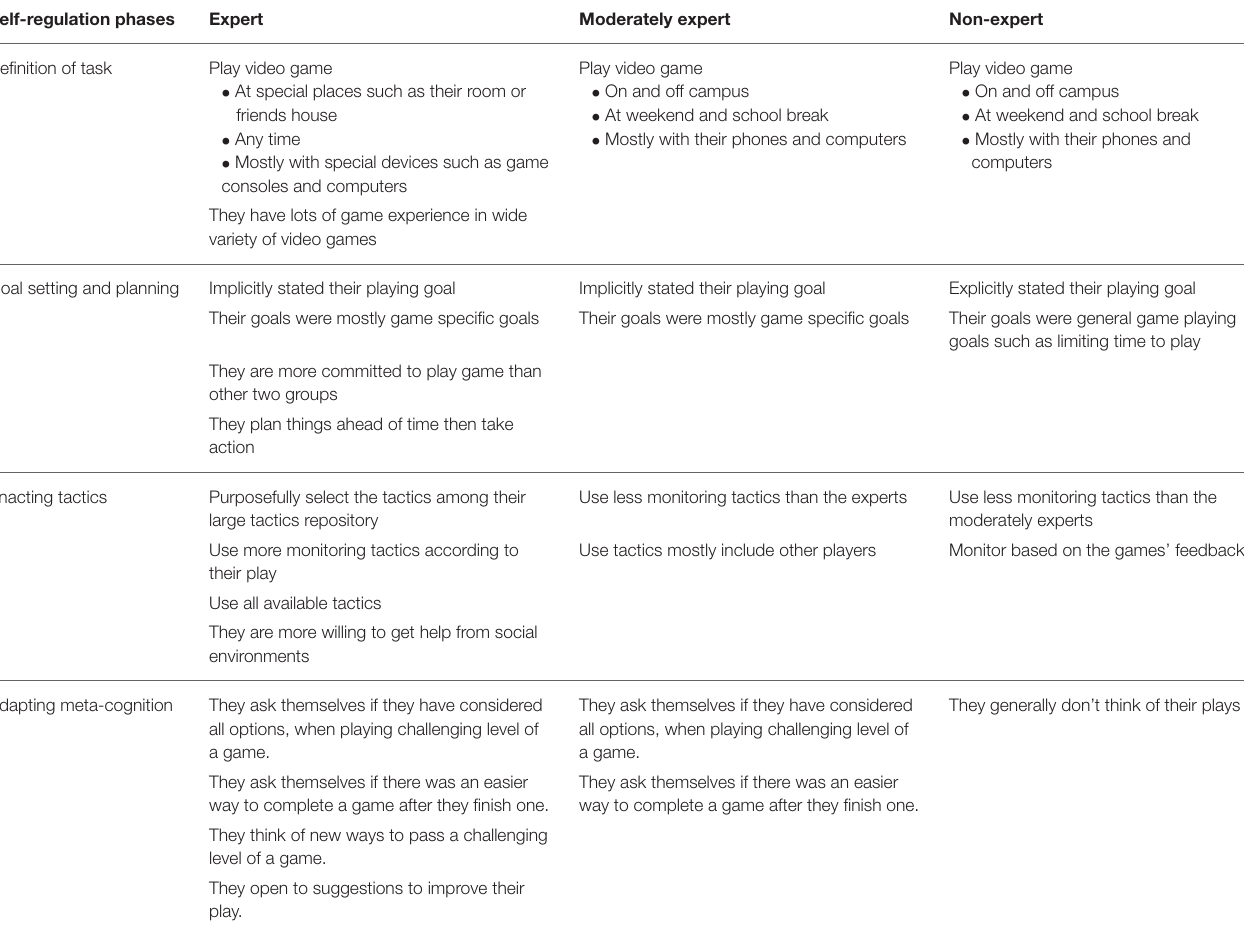
TABLE 7 | Summary of quantitative and qualitative